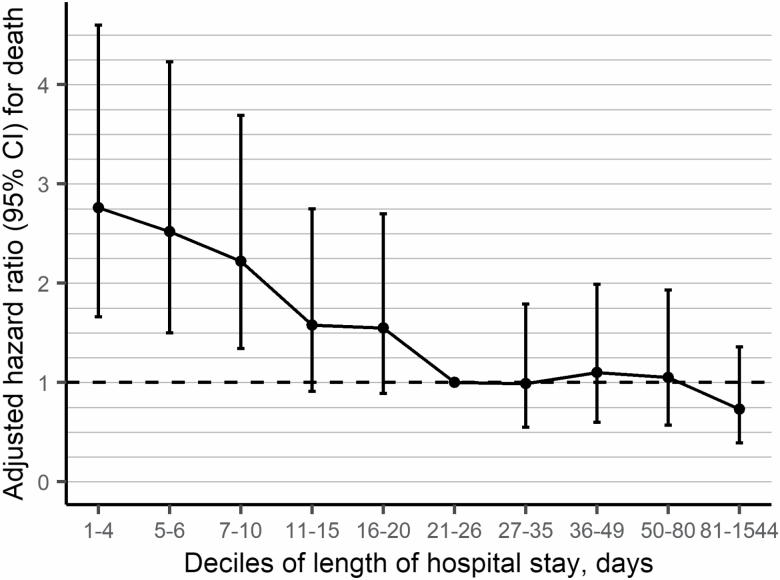
Adjusted hazard ratios for the association between deciles of length of hospital stay after hip fracture and mortality among persons with Alzheimer’s disease from the Cox regression model. Sixth decile (21–26 d) was a reference group. Vertical error bars show 95% confidence intervals. Analysis was adjusted for age, gender, occupational socioeconomic position, university hospital catchment area, time since diagnosis of Alzheimer’s disease, type of hip fracture, admission year, place of stay at admission, use of benzodiazepines and related drugs, antipsychotics, antidepressants, history of coronary artery disease, stroke, diabetes, asthma/chronic obstructive pulmonary disease, renal failure, any cancer, and required level of assistance after hospital discharge.